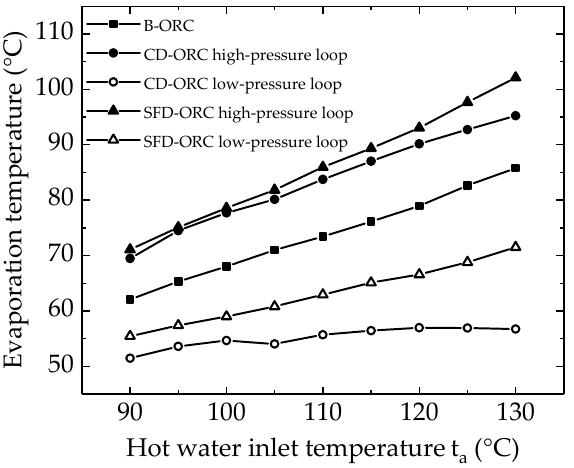
Figure 11. The optimal hot water temperature at the outlet of evaporator 1. Energies 2020 , 13 , x